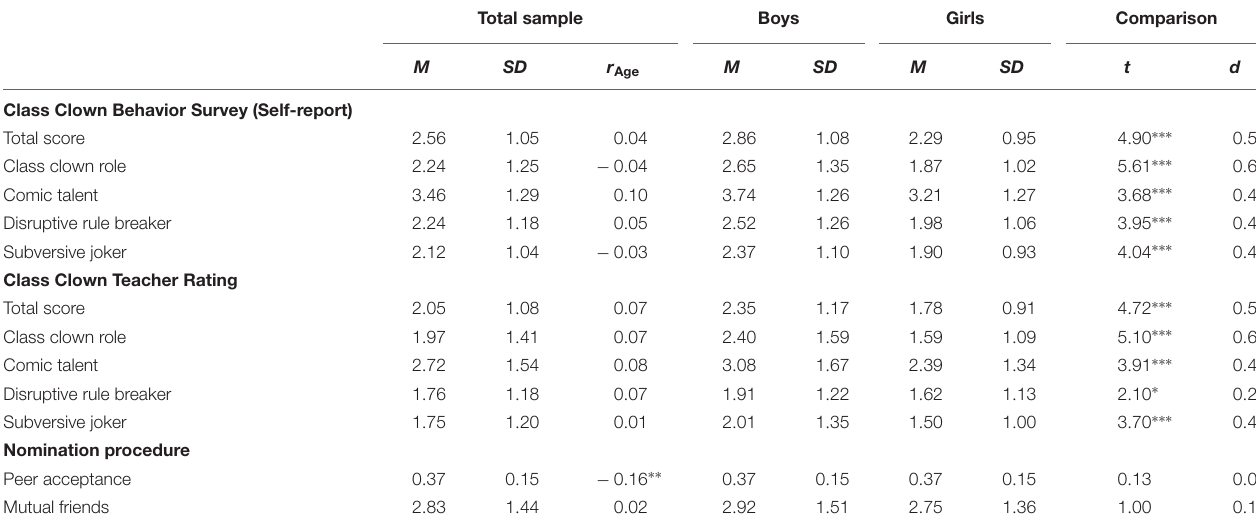
TABLE 1 | Descriptive statistics and correlations with sex and age for study